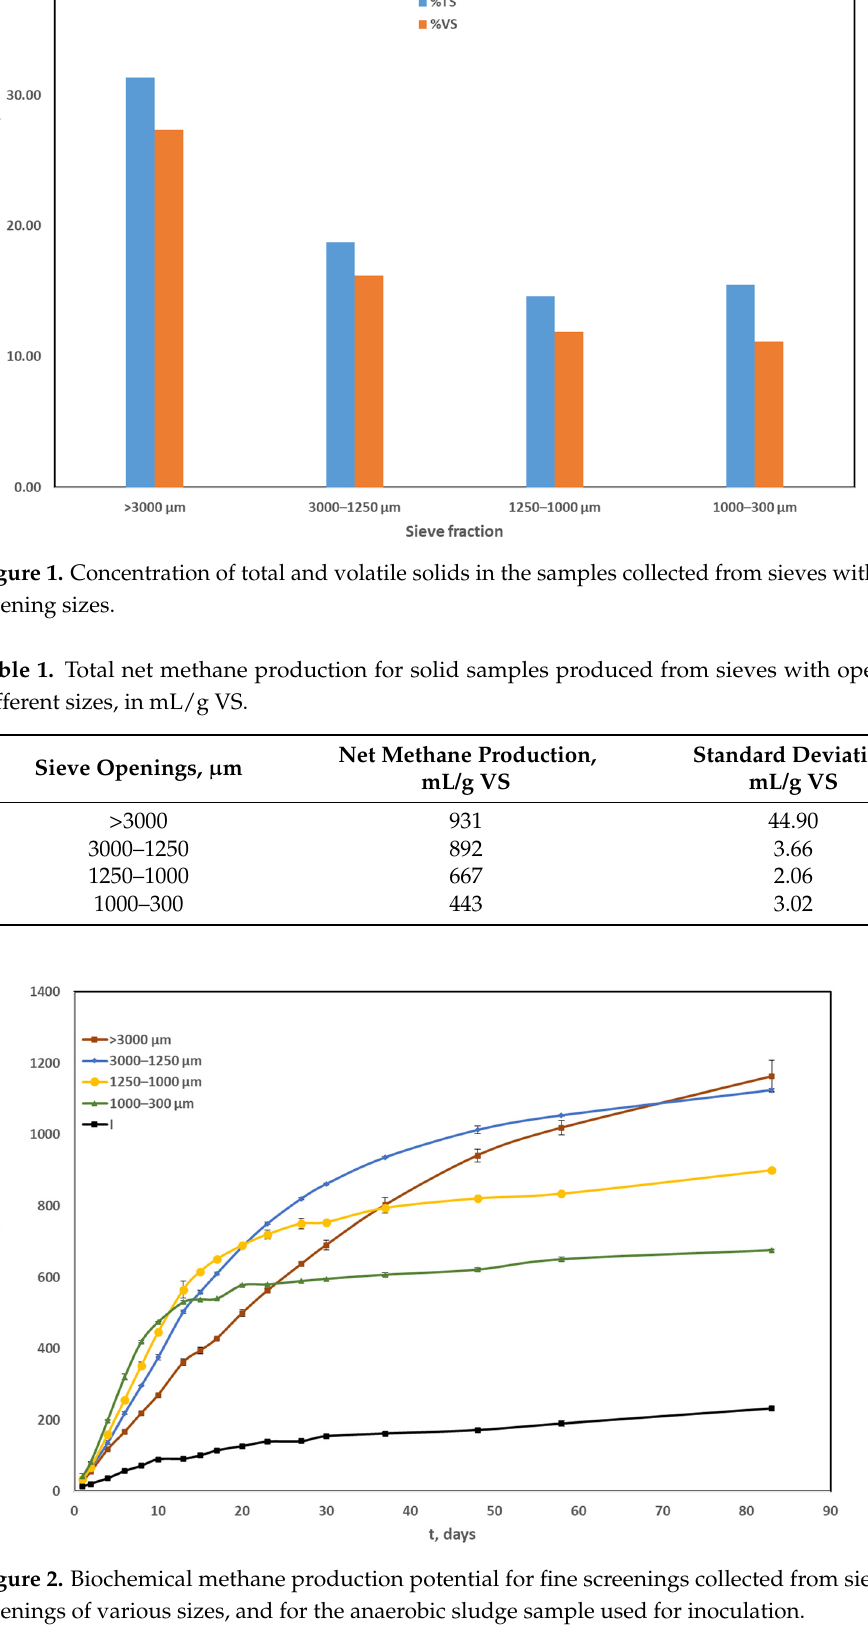
Figure 3. Maximum specific growth rate, μ max, and methanogen doubling time, Tdouble max, es- timated from the biochemical methane potential curves of solid fractions collected from sieves with various opening sizes. 3.2. Analysis of Cumulative Sieve Fractions The above results can lead to valuable information about the energy potential of dif- ferent sizes of fine solids that can be collected through the primary screening of raw influ- ents in a municipal wastewater treatment plant. Such an approach requires the installation of a series of fine sieves of reducing mesh size in the primary stage of a treatment plant; however, such a venture is usually not implemented due to space limitations and financial constraints. A rational approach would require the evaluation of the energy content of the total solids accumulated in a single size of fine screen. Therefore, the analysis of the char- acteristics and the energy content of accumulated solids collected in sieves with various